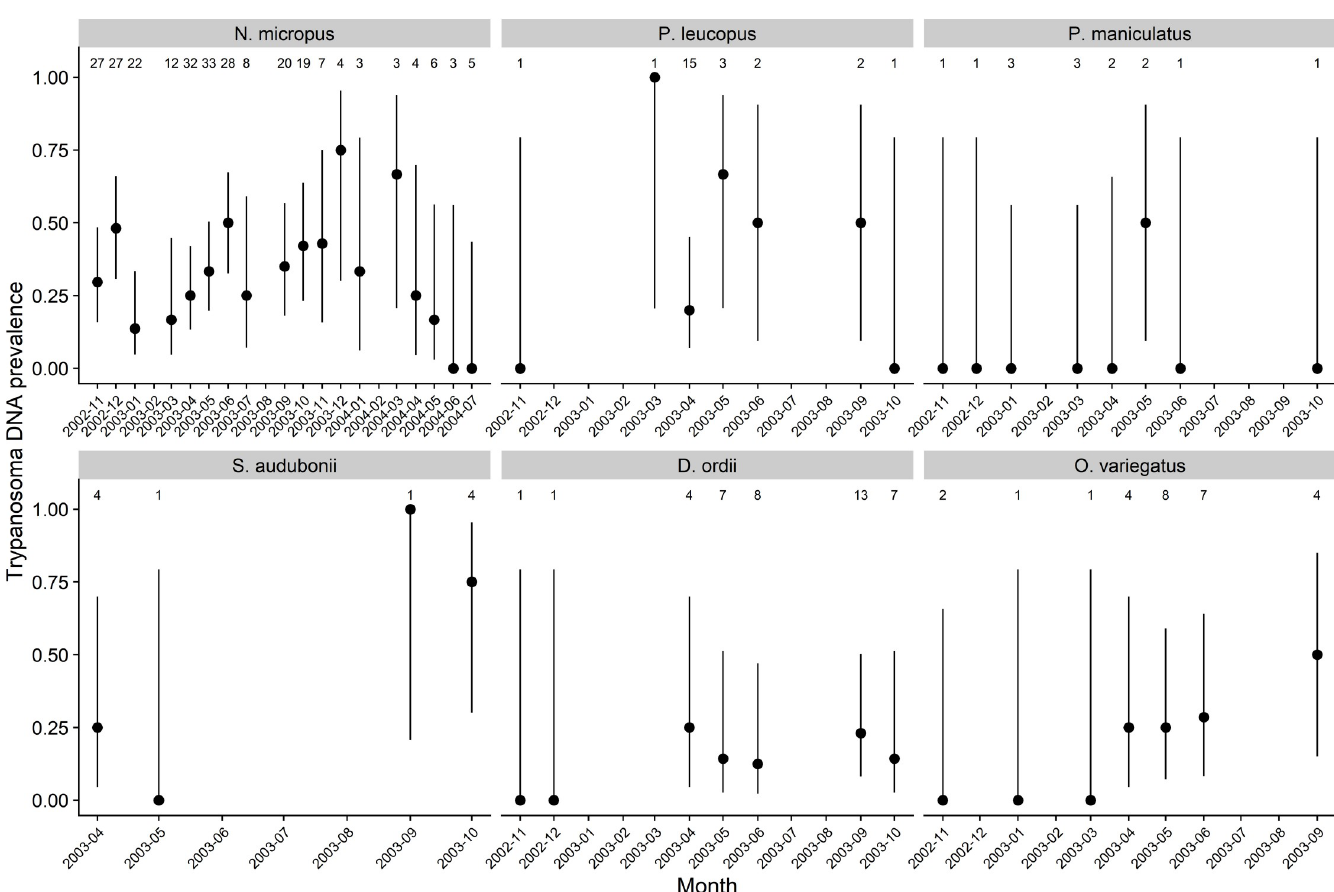
Fig 1. Trypanosoma DNA prevalence in positive host species over time. Circles show estimated prevalence and lines show 95% Wilson score confidence intervals. Numbers above each panel show the total individuals of the species tested in a